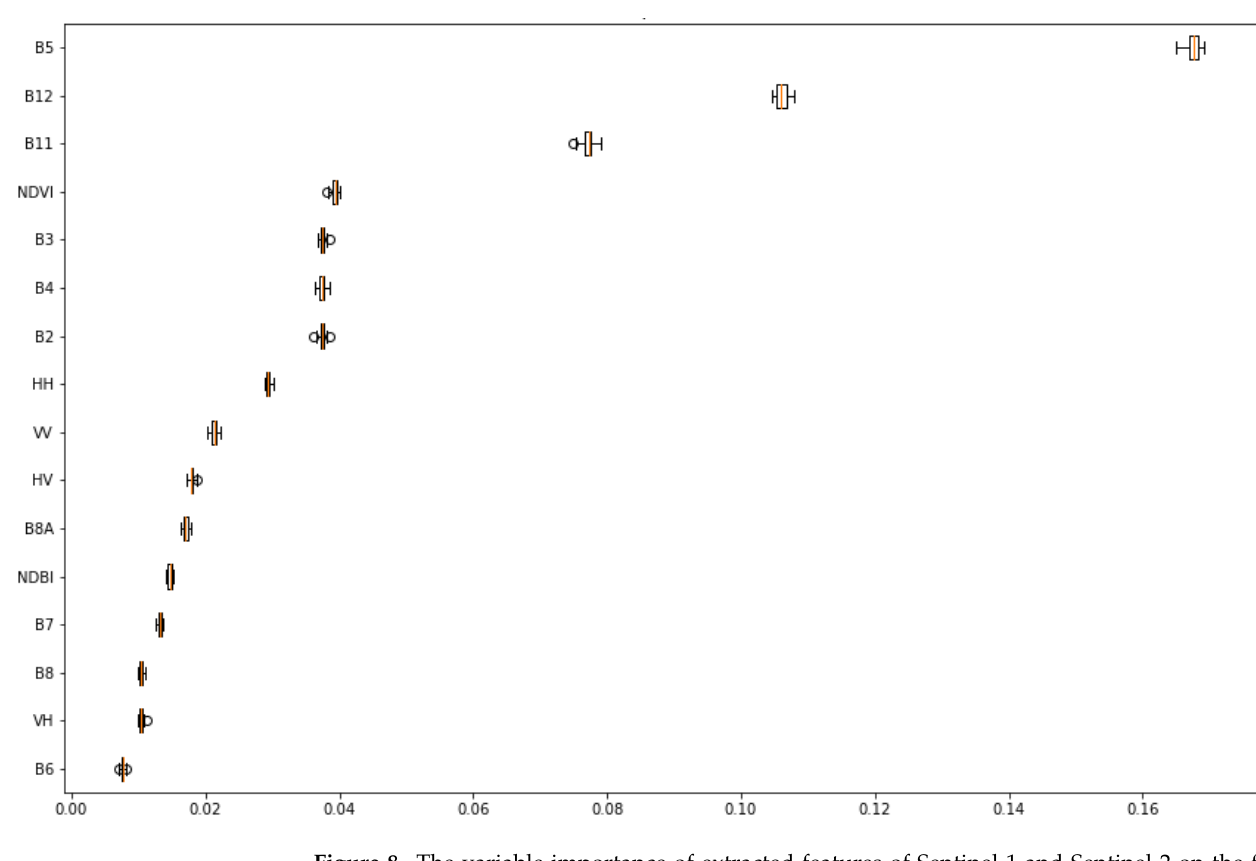
Figure 8. The variable importance of extracted features of Sentinel-1 and Sentinel-2 on the final coastal wetland classification by the RF classifier based on the Gini importance index.